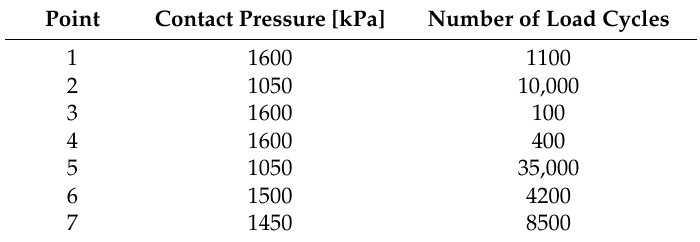
Table 7. Second trial section investigated points, FastFWD load levels, and number of load